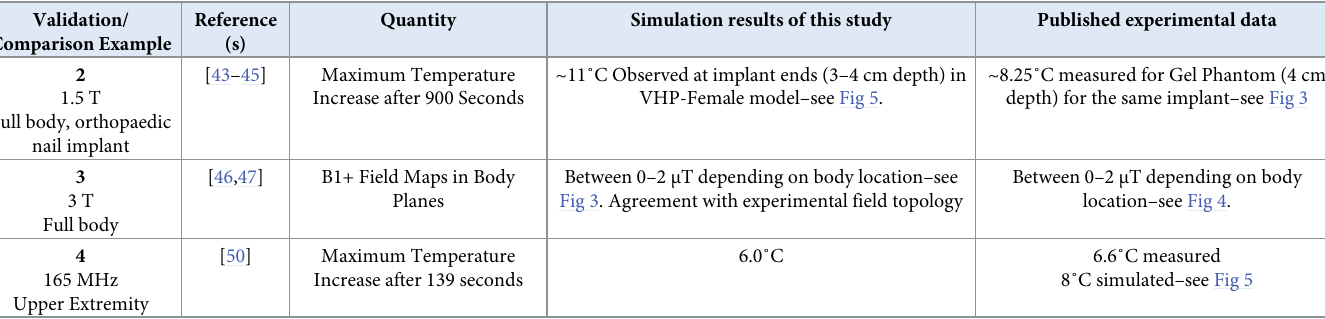
Table 2. Comparison of simulated numerical results using the VHP Female computational model with experimental results for examples 2, 3, and 4. Validation/ Reference Comparison Example